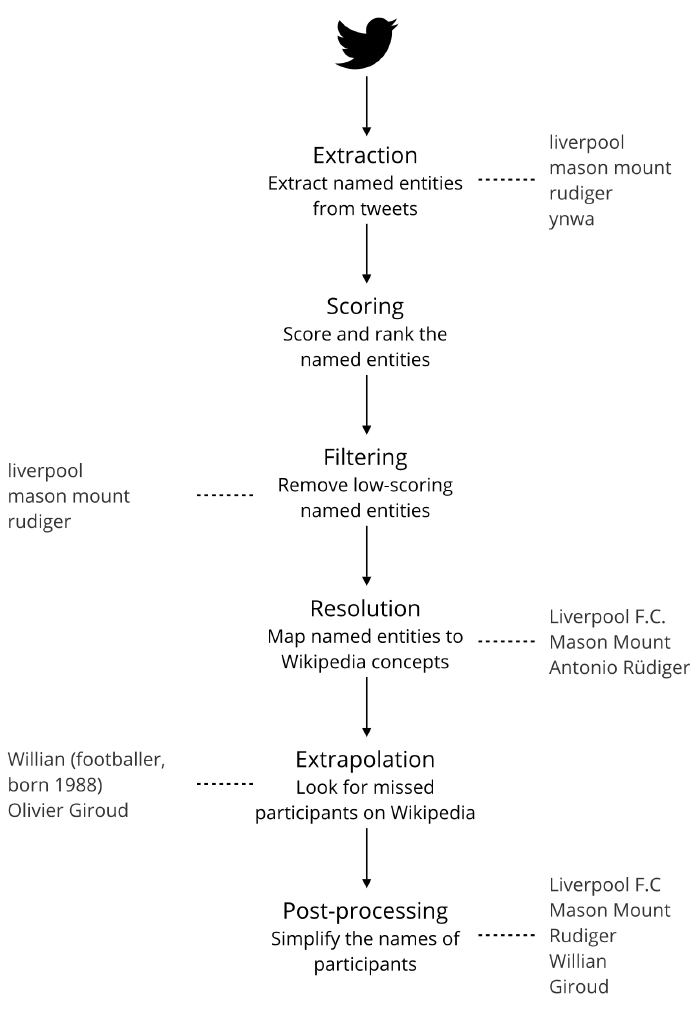
Figure 2. The process of the APD (Automatic Participant Detection) framework takes as input a corpus of tweets collected before an event and outputs a list of event